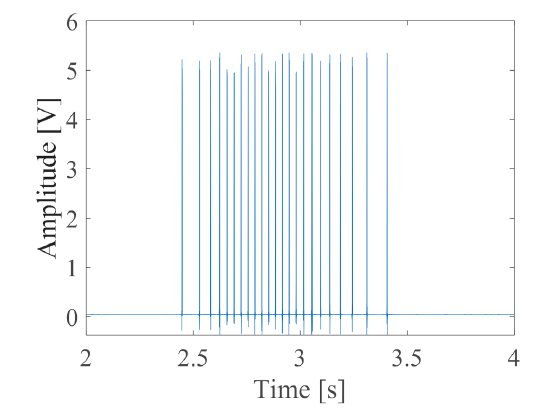
Figure 6. Pulse signal collected in outer race fault experiment.